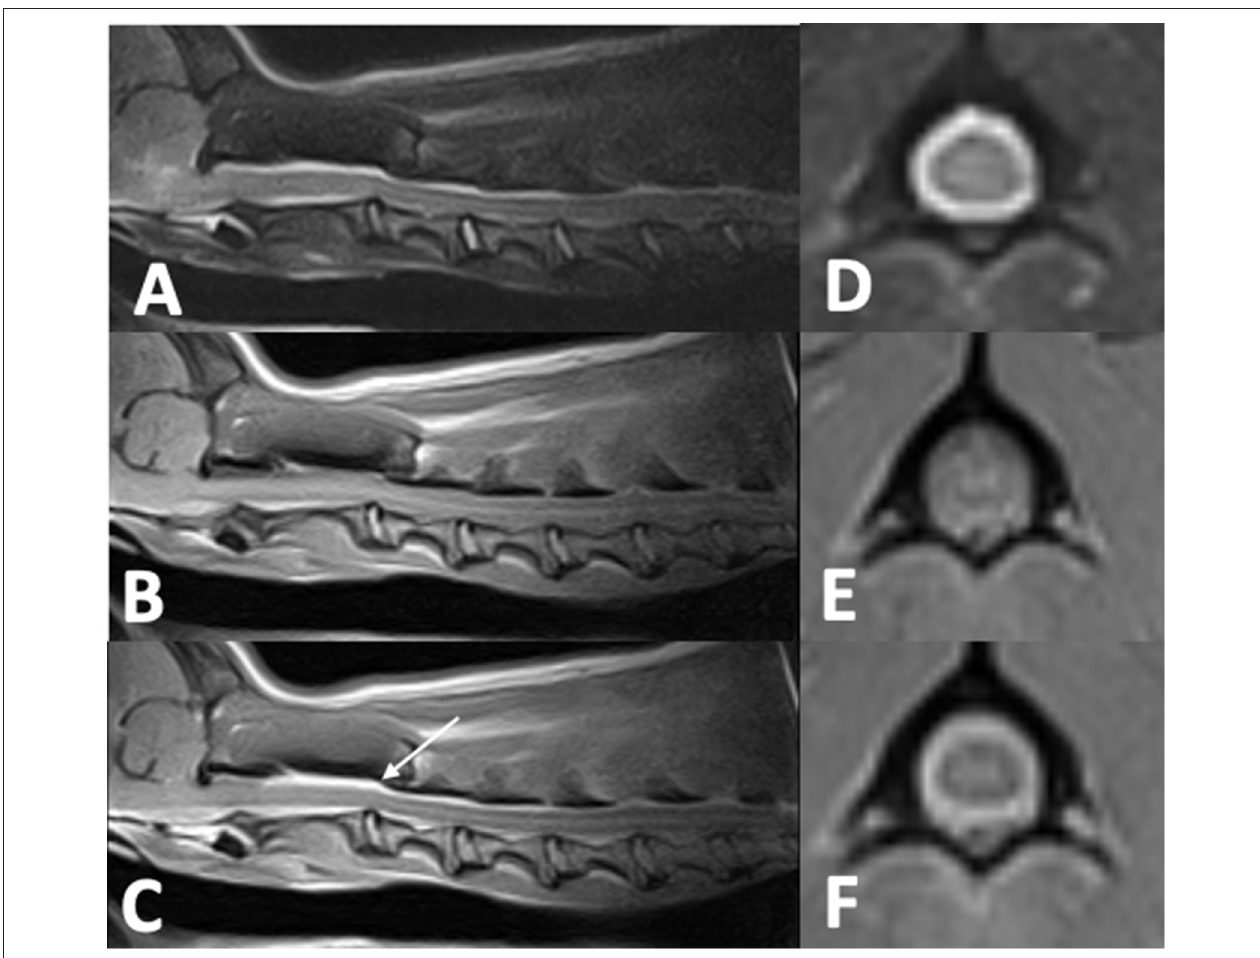
FIGURE 2 | Cervical MRI in an 11-month-old 8.3kg sexually intact male dachshund with an acute onset of cervical pain (case two). (A) —T2W sagittal image of the cervical spine that is unremarkable. (B) —T1W sagittal image of the cervical spine that is unremarkable. (C) —T1W post-contrast sagittal image of the cervical spine with dorsal and ventral meningeal contrast enhancement from C1–C4 (arrow). (D) —T2W transverse image at the level of C1 that is unremarkable. (E) —T1W transverse image at the level of C1 that is unremarkable. (F) —T1W post-contrast image at the level of C1 showing circumferential meningeal contrast